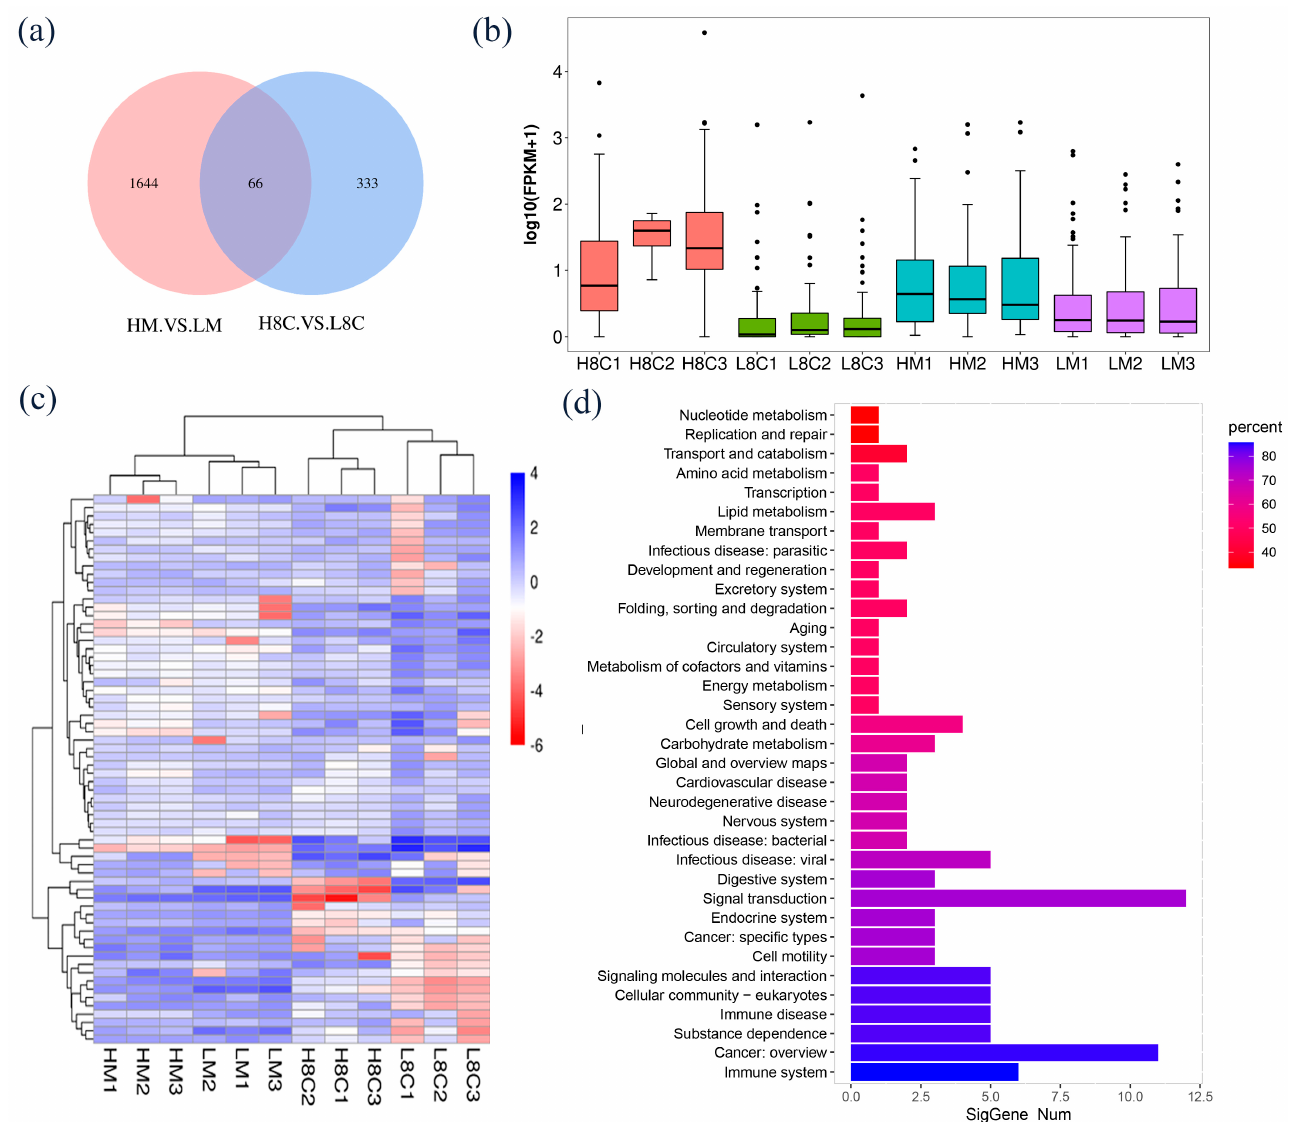
Figure 5. Hub gene identification and DEGs’ protein–protein interaction analysis. ( a ) Venn diagram of DEGs between the H8C and L8C embryos, and between the HM and LM embryos. ( b ) Boxplot of FPKM in the 8-cell stage and blastocyst stage embryos. Heatmap ( c ) and KEGG enrichment analysis ( d ) of 66 DEGs.